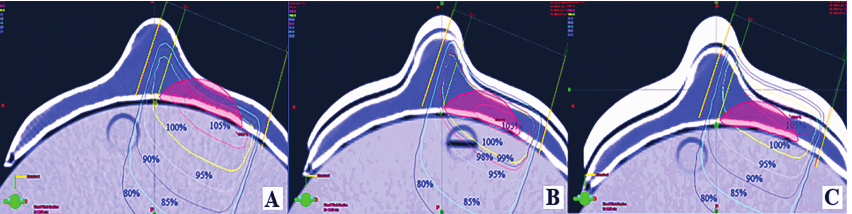
Figure 7. Isodose distribution in single field treatment plans: ( A ) CT head phantom with attached patient-specific phantom; ( B ) patient-specific phantom with attached 0.5 cm thick bolus; ( C ) patient- specific phantom with attached 1.0 cm thick bolus.